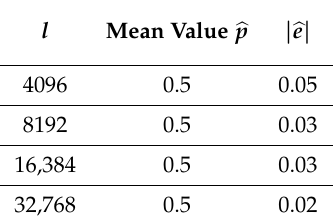
Table 2. Values of the deviation | (cid:98) e | for several l , l > l 0 = 2189 with n = 64 and m = 32. l Mean Value (cid:98) p | (cid:98) e